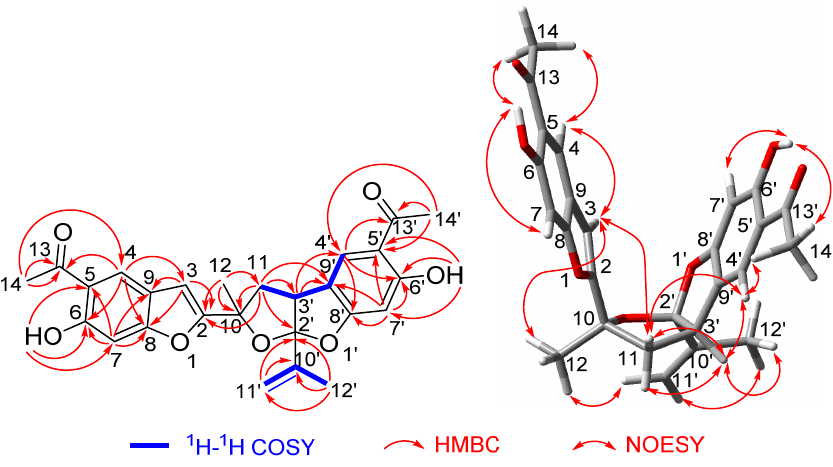
Figure 5. Key 2D NMR correlations for 4 . Compound 5 was obtained as yellow amorphous powder. The [M + H] + peak at m / z 461.1601 in HRFABMS determined its molecular formula to be C 27 H 24 O 7 , indicating 16 de- grees of unsaturation. The IR spectrum revealed the presence of hydroxy (3245 cm − 1 ) and conjugated carbonyl groups (1672 cm − 1 ), as well as an acetylenic moiety (2225 cm − 1 ). Table 2. 1 H (500 MHz) and 13 C (126 MHz) NMR data of 4 and 5 in CDCl 3 .